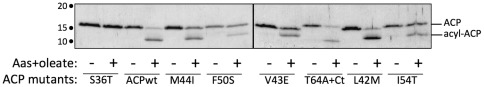
In vitro acylation assay of purified ACP mutants.The indicated purified ACP mutants were assayed for acylation with oleate using acyl-transferase Aas enzyme (see Material and Methods). ACP species were analyzed on a 15% SDS-PAGE stained with Coomassie Blue. Molecular weight markers in kDa are indicated on the left-hand of the gel.